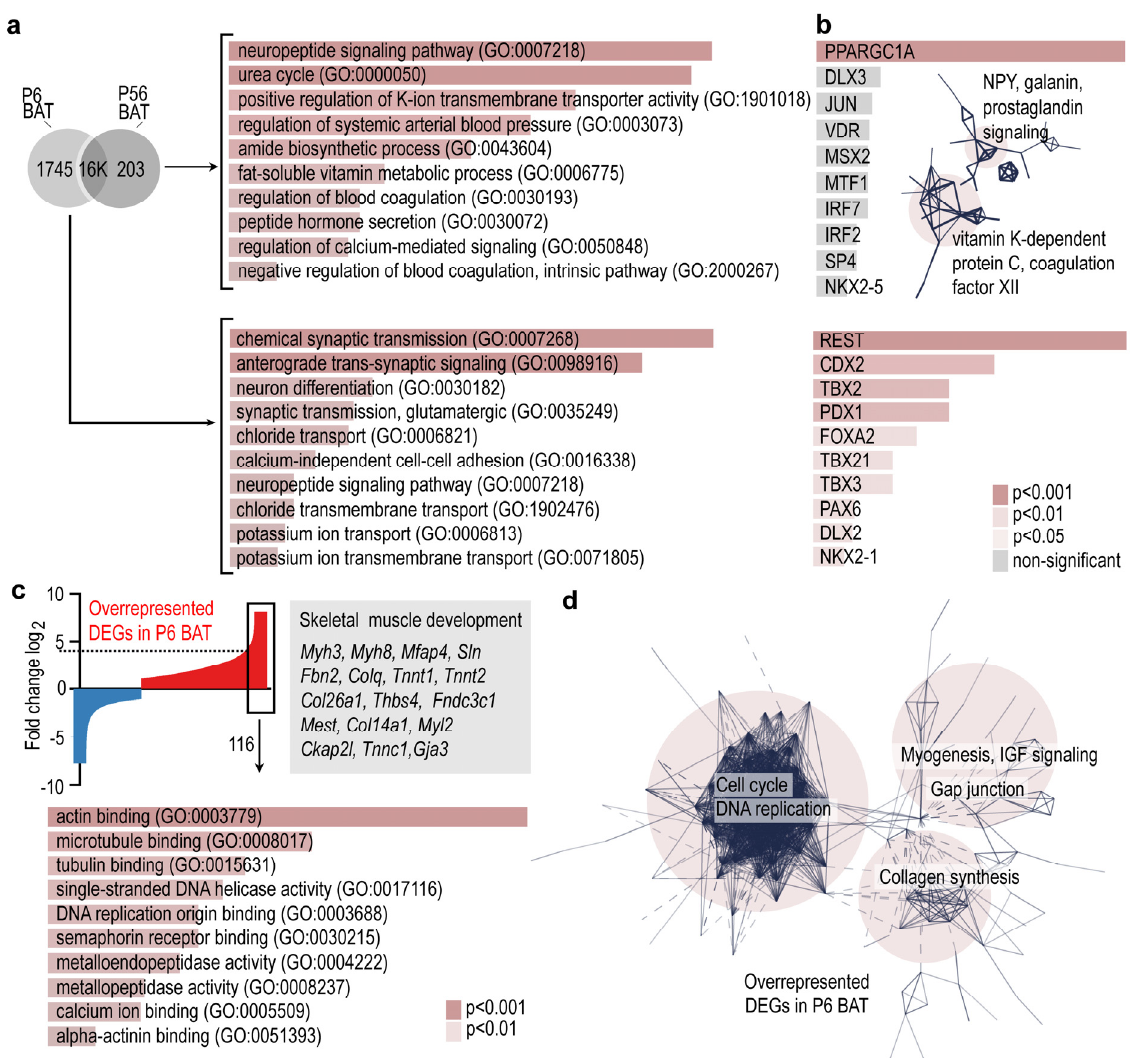
Figure 2. Gene ontology analysis and gene networks of BAT-specific transcripts. ( a ) Venn diagram showing uniquely expressed genes in P6 BAT or P56 BAT. GO terms associated with P6-, and P56-specific transcripts. ( b ) Transcription factor-binding prediction for P6-, and P56-specific transcripts. Inset shows gene networks of P56-specific transcripts. Combined p -values of the enrichment are shown in color codes in panels a and b. ( c ) Top: Gene expression profiles of P6 and P56 BAT were compared, and the differences were visualized on the Y-axis as log 2 of fold change of DEGs. DEGs overrepresented at P6 are indicated in red, and underrepresented DEGs are shown in blue. The 116 DEGs which were ≥ 4.5-fold overrepresented in P6 were analyzed further. Bottom: GO terms of the 116 most overrepresented DEGs. ( d ) Interactome map of DEGs overrepresented in P6 BAT. PPI enrichment p -value < 1.0 × 10 − 16